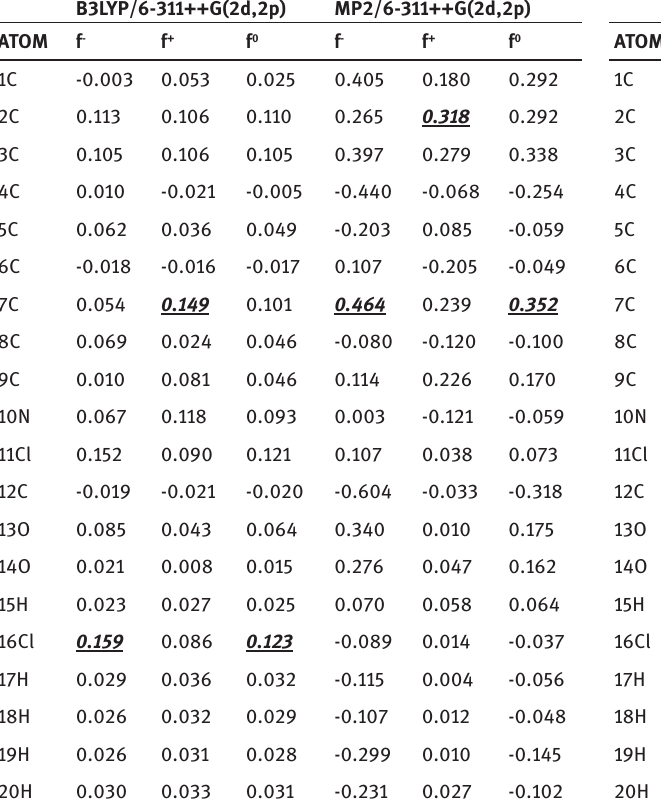
Table 3: Values of the condensed Fukui function in quinclorac computed from NBO charges according to Eqs. 9, 11, 12 in gas phase.